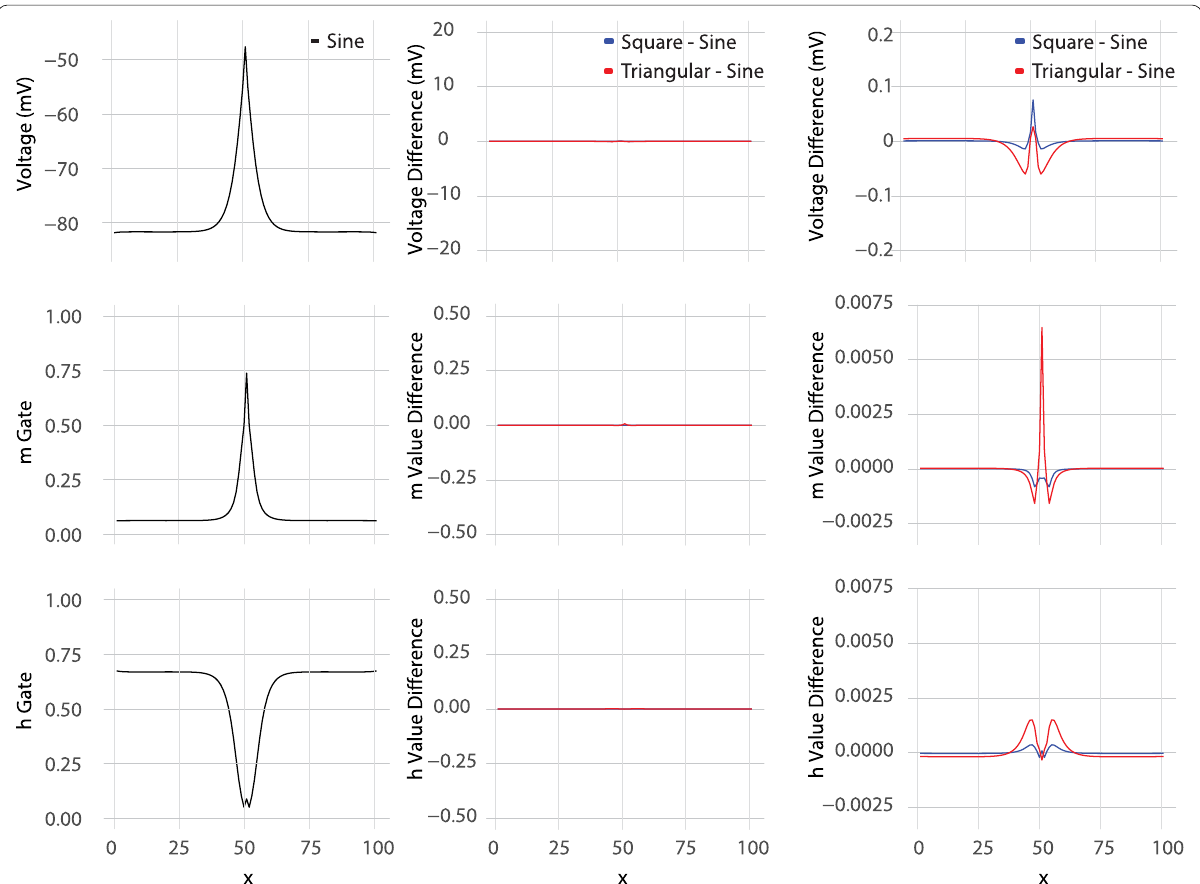
Fig. 5 Profile plots showing all transmembrane nodal voltages, m gate, and h gate values in the top, middle, and bottom rows respectively. All values shown are averaged over a single period of the 10 kHz stimulating waveform. The left column shows the profiles from sinusoidal waveform stimulation. The middle column shows the difference between the triangle and sinusoidal stimulation profiles (in blue) and the difference between the square and sinusoidal stimulation profiles (in red). The middle profile differences are shown with the same y-axis scale as the profiles in the left column. The right column is the same data shown in the middle column, but with a 100 times zoom on the